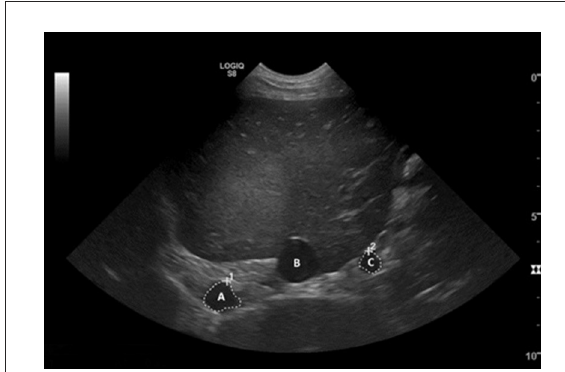
FIGURE1 Transverse ultrasound image of the liver. The aorta (A), caudal vena cava (B), and portal vein (C) are visible in cross-section, with the white dashed lines measuring the cross-sectional area of the aorta and portal vein. The area of the portal vein was obtained by acquiring a transverse image of the vessel (perpendicular to its long axis) and traced its outline. From this tracing, the area was calculated by the ultrasound machine software. The same measurement was acquired for the aorta at the same level and the area calculated in the same manner.